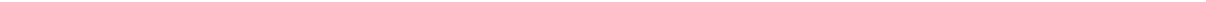
Fig. 7 Model validation: IFN β pre-stimulation increases the fraction of responding cells and response strength. Following 24 h of quiescence ( a , b ) or pre- stimulation with 1000 U/ml IFN β ( a , d ), WT MEFs were stimulated with 1 μ g/ml poly(I:C) for 0 – 24 h, or they were only stimulated with 1000 U/ml IFN β for 0 – 24 h ( c ). a Protein levels of model components, characterised by western blotting and numerical model simulations. Whole-cell extracts were analysed with antibodies against NF- κ B – IRF3 – STAT1/2 pathways components. (*) = IKK isoform-dependent phosphorylation sites: p-IKK α Ser176/180,